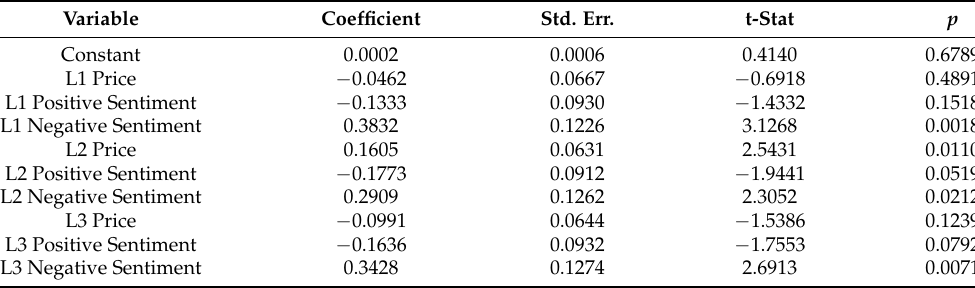
Table A2. VAR results for the regressions on aggregate positive sentiment. Optimal lag length was selected using a built in function in the VAR submodule of the statsmodels module in Python. Lx before a variable name denotes that a variable was lagged ×